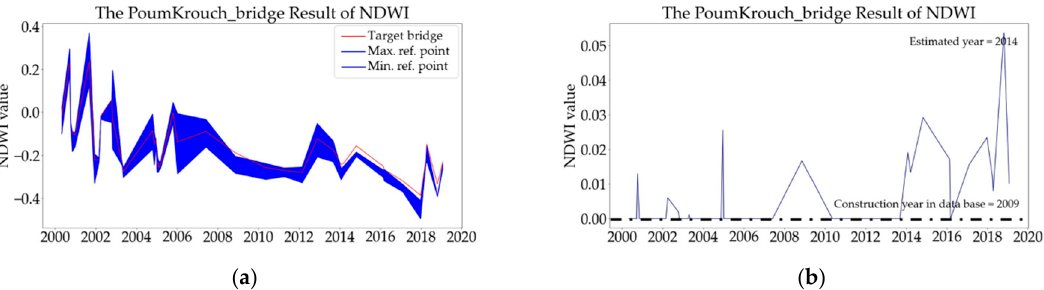
Figure 29. Satellite images of the Poum Krouch bridge from which the year of construction cannot be judged.